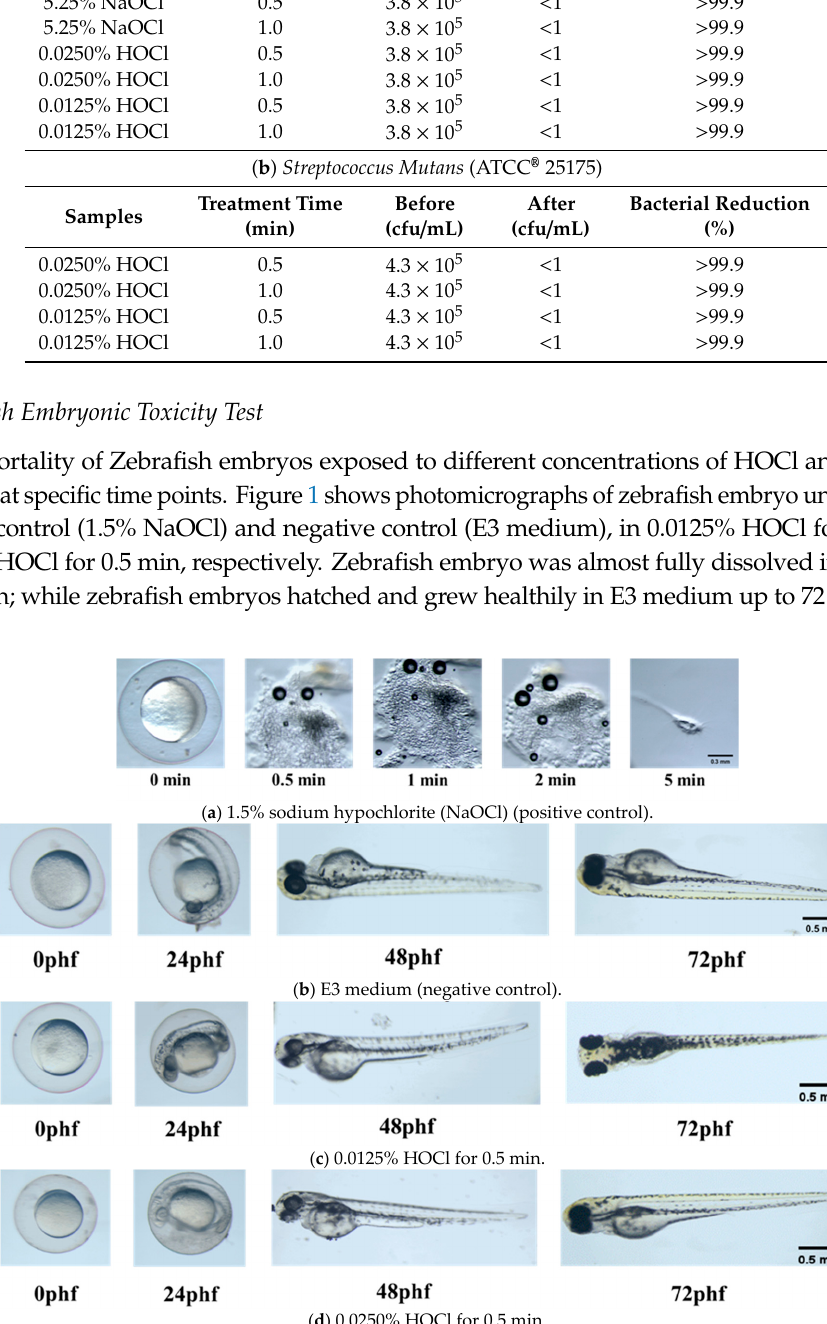
Table 1. Bacterial counts and reduction of ( a ) E. faecalis and ( b ) Streptococcus mutans before and after treatment.